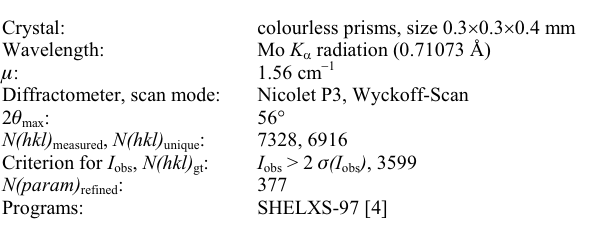
Table 1. Data collection and handling.